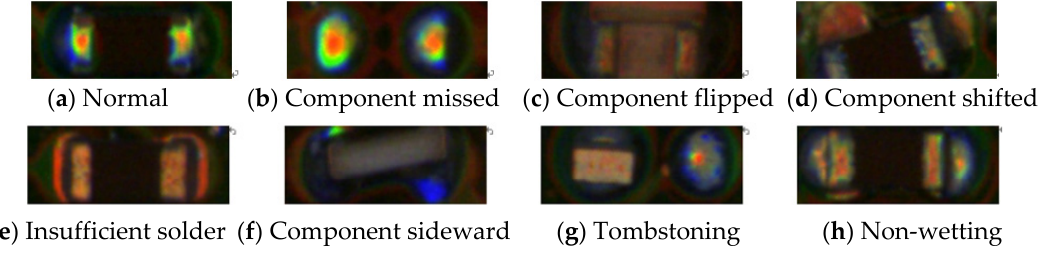
Figure 4. Defects of PCB.